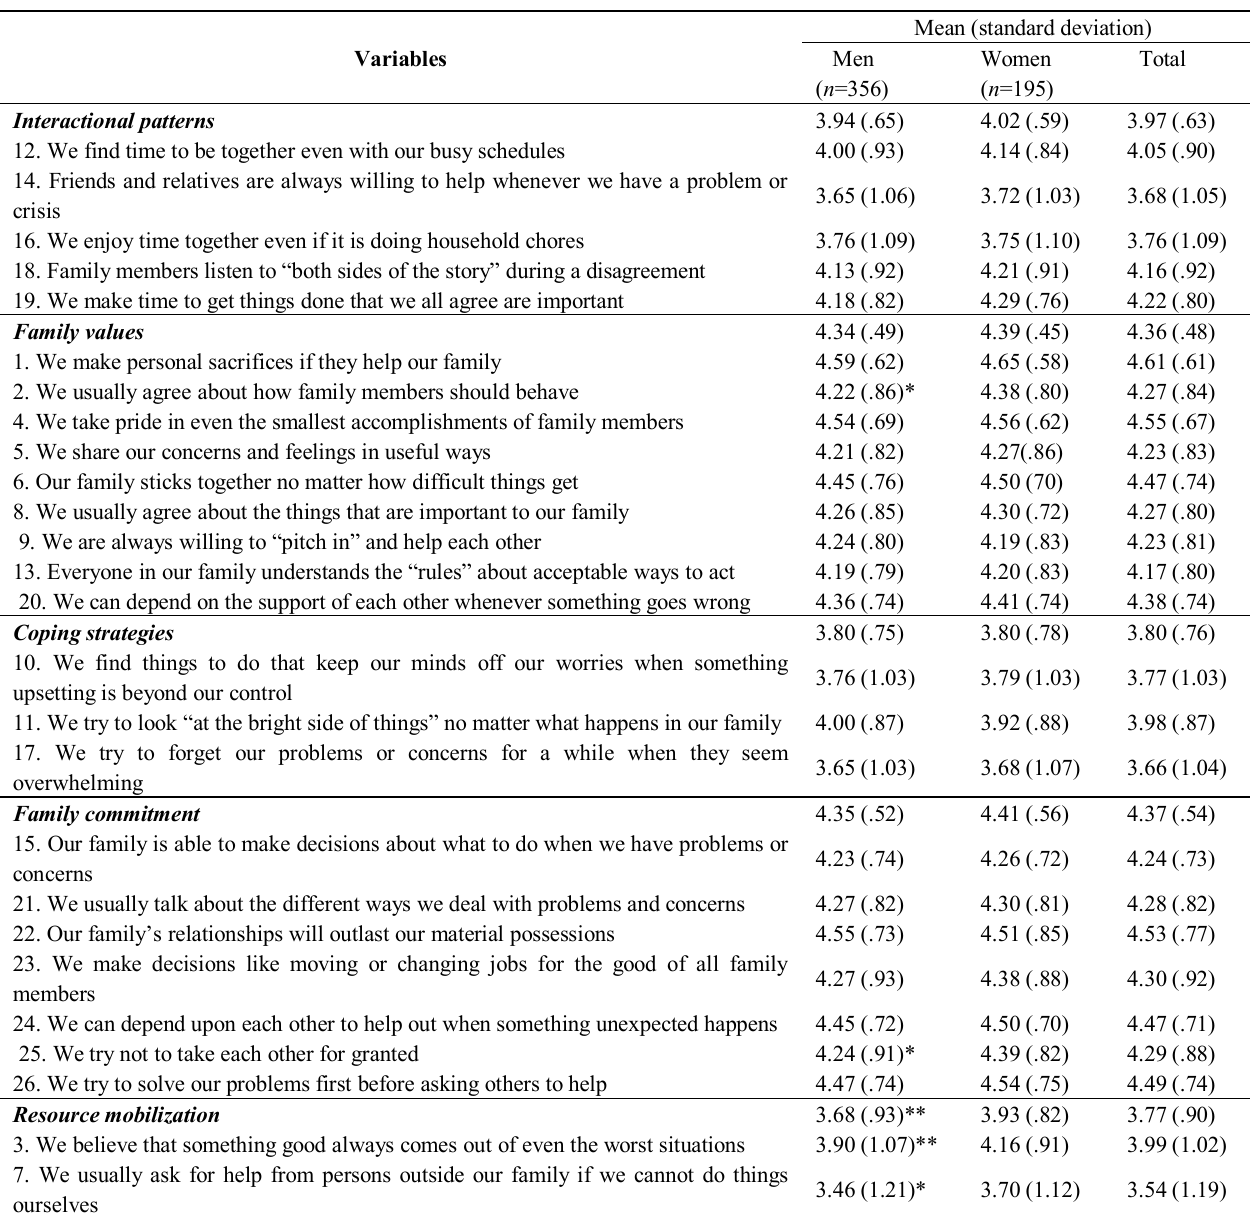
Tabel 3. Exposure to Family Functioning Style Topics by